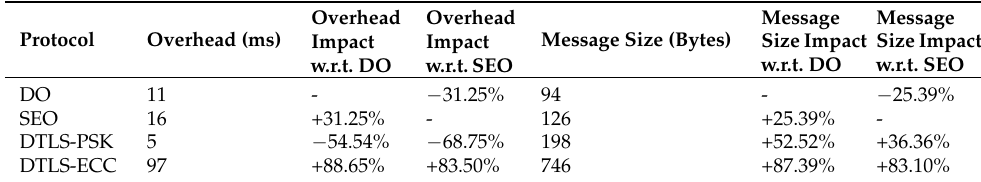
Table 12. System-based comparison for DTLS-PSK, DTLS-ECC and extended LoRaWAN protocol with DO and SEO